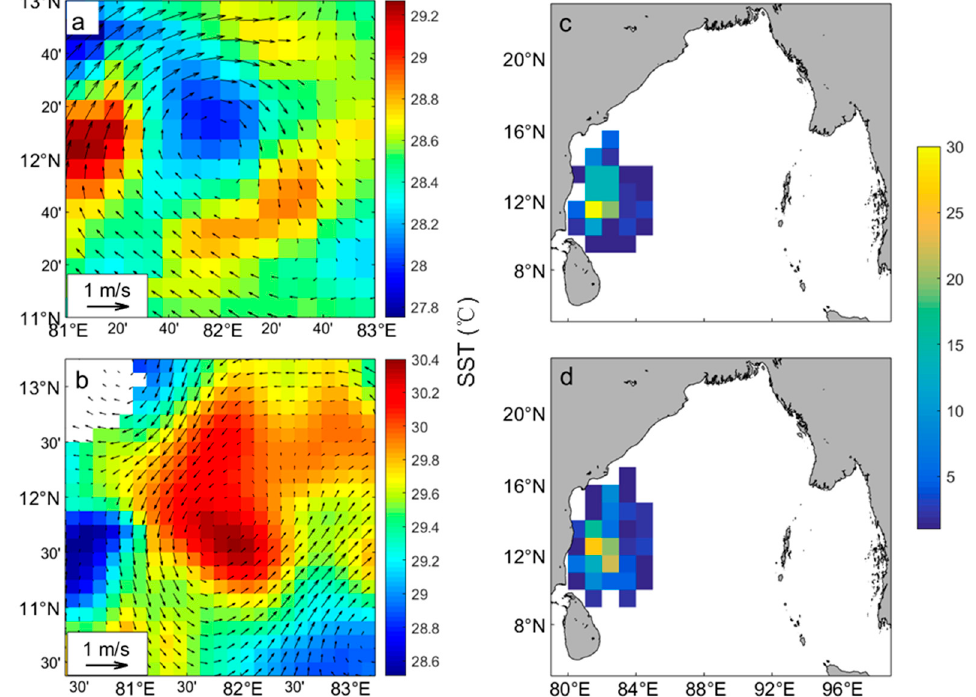
Figure 16. Abnormal eddy for AEs ( a ) and CEs ( b ) and spatial distribution (lifetime ≥ 4 weeks) over 1° × 1° bins for AEs ( c ) and CEs ( d ), where the arrow indicates geostrophic velocity anomalies and the color indicates the temperature.